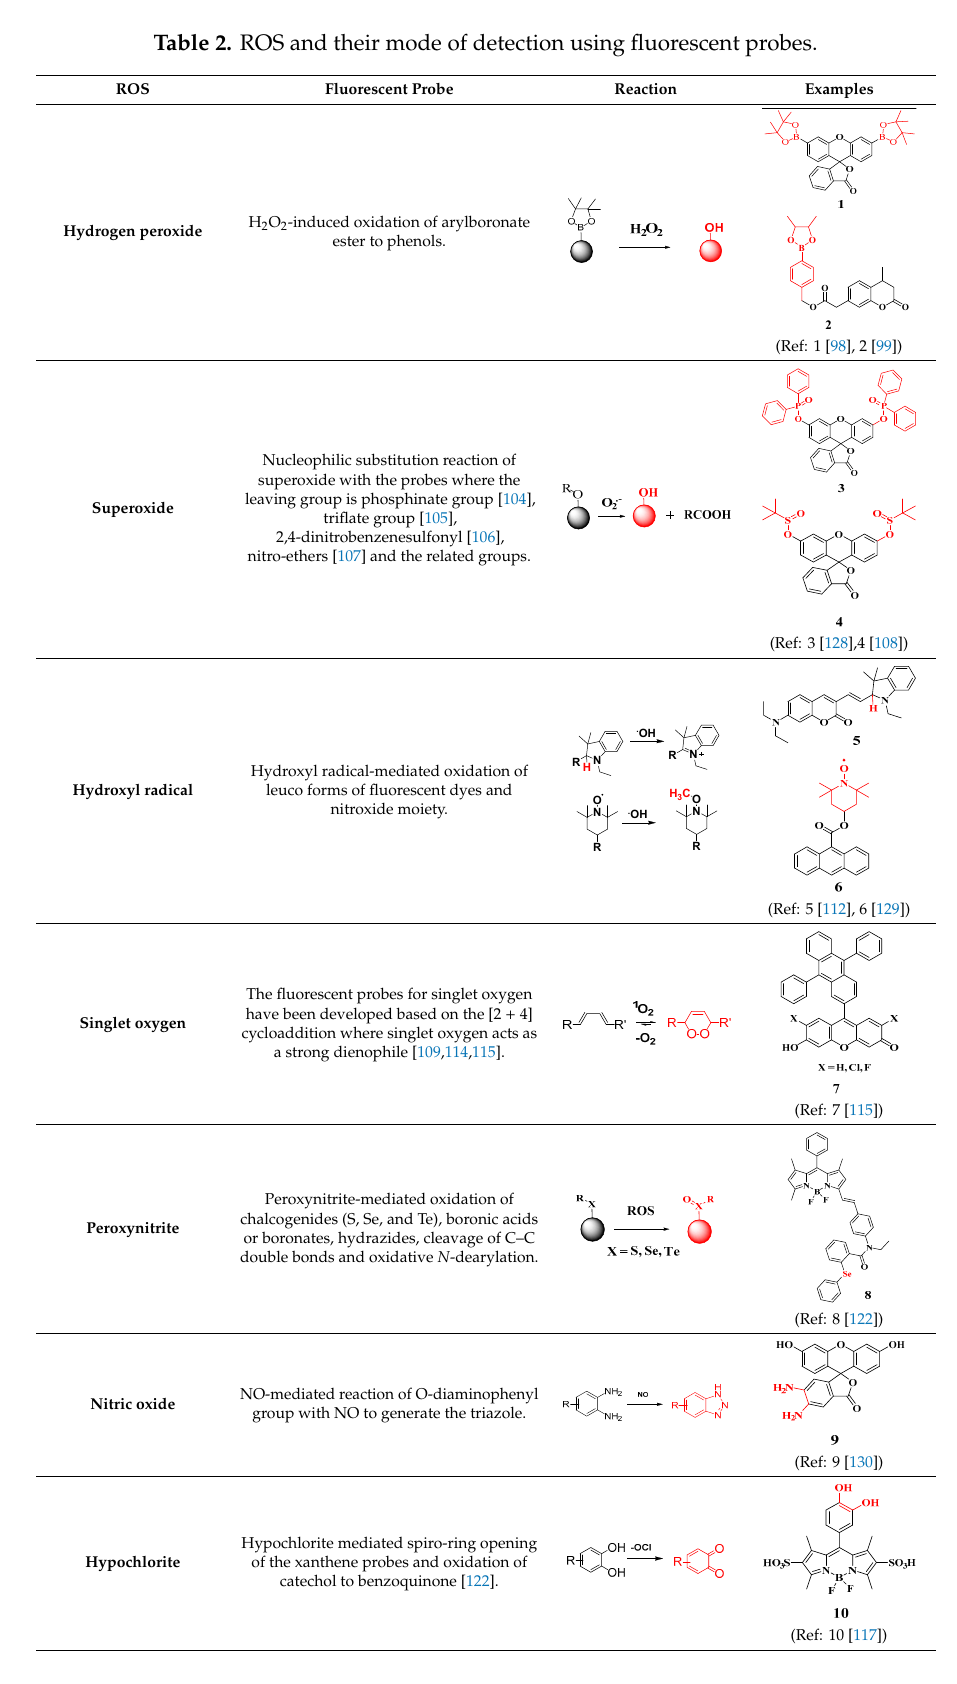
(Ref: 10 [117]) (Ref: 10